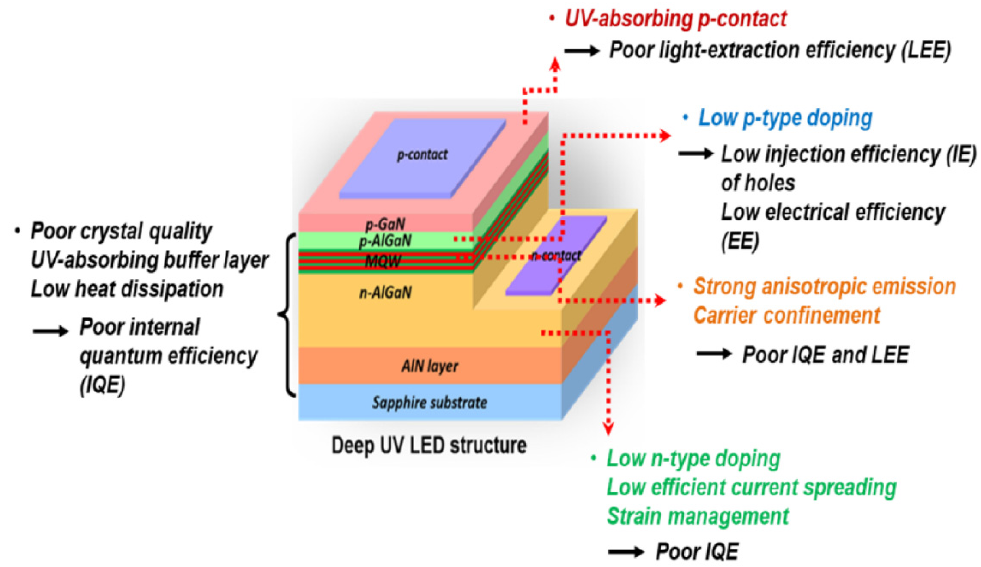
Figure 3. The schematic diagram of a typical UV-LED and related physical phenomenon associated with different layered structures. [12] Copyright 2021, MDPI Publishing. with different layered structures. [12] Copyright 2021, MDPI